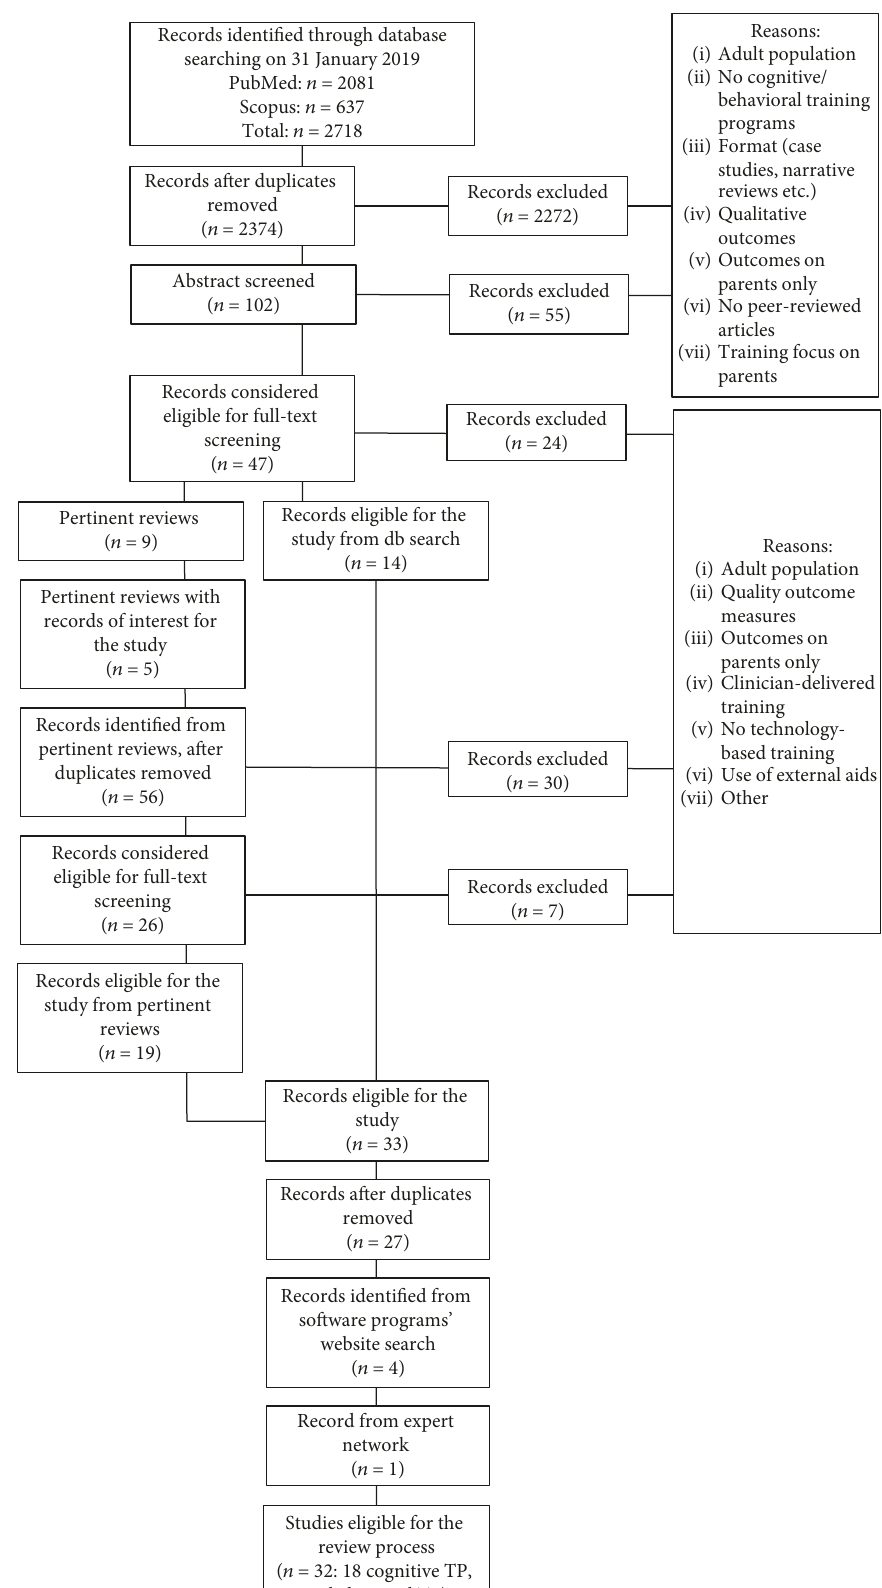
Figure 1: Graphical depiction of the study inclusion